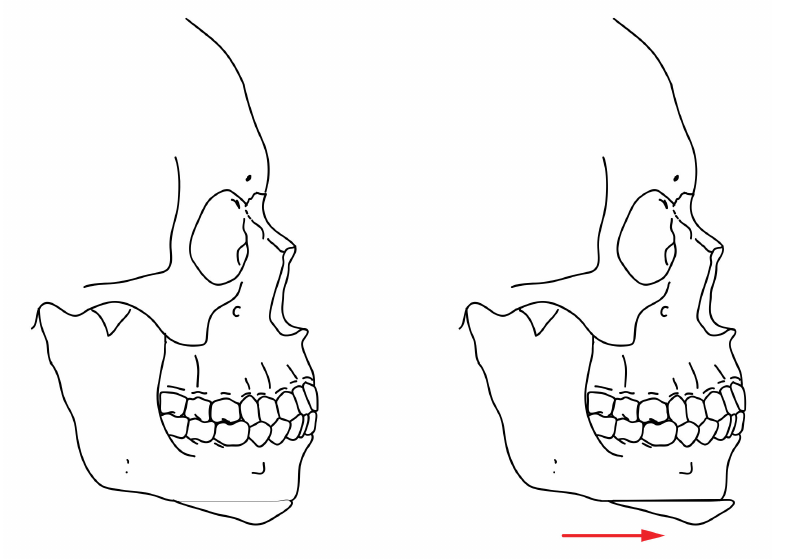
Figure 5. Schematic view of